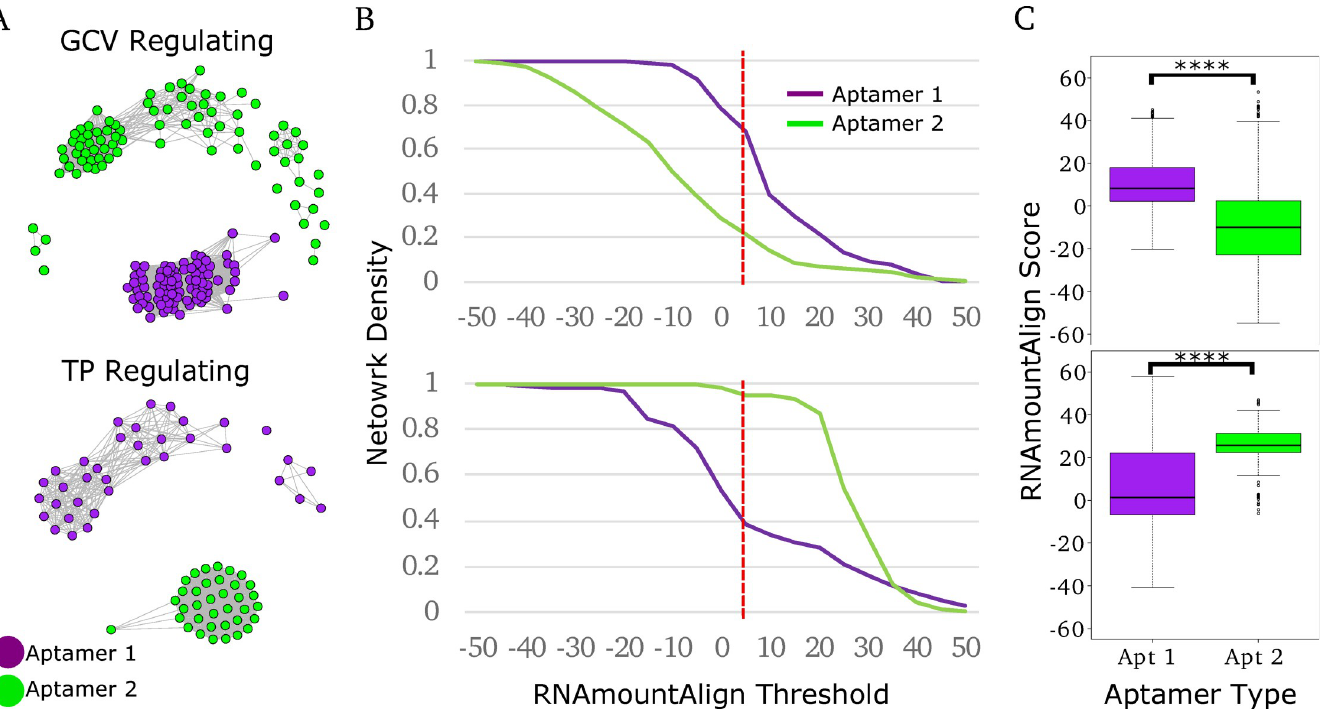
Fig 2. Clustering of tandem riboswitch aptamers across Bacillaceae and Vibrionaceae. A) Bacillaceae and Vibrionaceae tandem riboswitch aptamers were clustered using RNAmountAlign as a distance metric (threshold of 5). All represented Bacillaceae riboswitches regulate GCV (top), while Vibrionaceae riboswitches regulate TP (bottom). Aptamers are colored based on aptamer type, purple for aptamer-1 and green for aptamer-2. B) Network density was calculated for each aptamer in both networks across a range of RNAmountAlign thresholds. Dotted red line indicates the RNAmountAlign threshold (5) at which the networks in A were visualized. C) Box blots represent all pairwise edge-weights within each aptamer type. ���� p-value < 2x10 -16 .